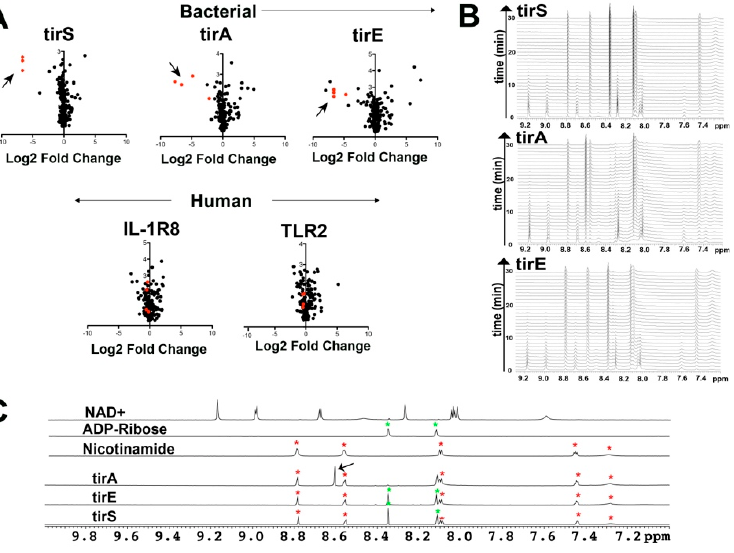
Figure 2. Characterizing TIR-containing catalytic activity. ( A ) Volcano plots derived from MS analysis are shown for 24 h incubations of 1 µ M bacterial TIR proteins that include tirS, tirA, and tirE and mammalian TIR domains from IL-1R8 and TLR2 incubated in protein-depleted RBC extracts relative to a buffer control. Arrows delineate the reduction in NAD + , NADP + , NADH, and NADPH (red). ( B ) The time course of one-dimensional NMR spectra is shown for 1 mM NAD + after incubation with 1 µ M tirS, 43 µ M tirA, and 25 µ M tirE. ( C ) 1D-spectra of NAD + , ADP-ribose, and nicotinamide along with the product spectra of NAD + incubated with tirS, tirA, and tirE. Resonances from ADP-ribose and nicotinamide are denoted green and red, respectively, while the arrow denotes the single difference within tirA.